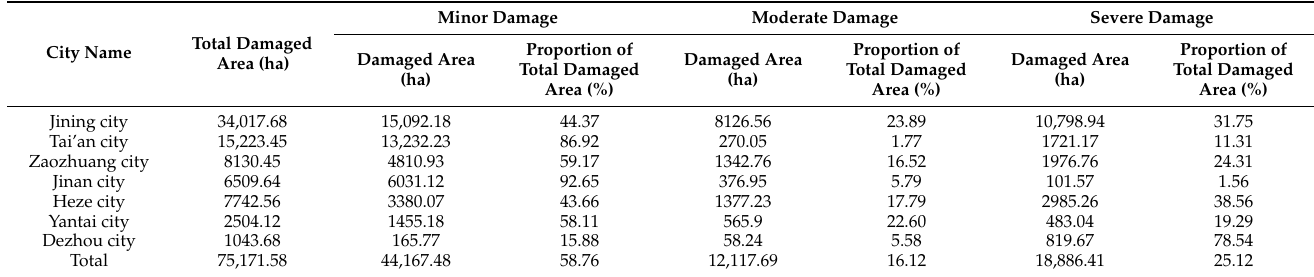
Table 6. Prediction of damaged farmland area by 2030 in